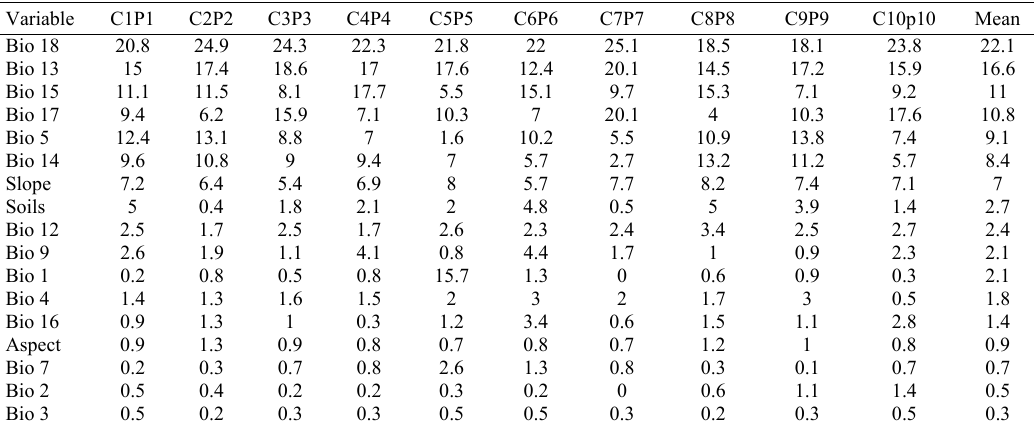
Table 6. Percent variable contribution to the Maxent model